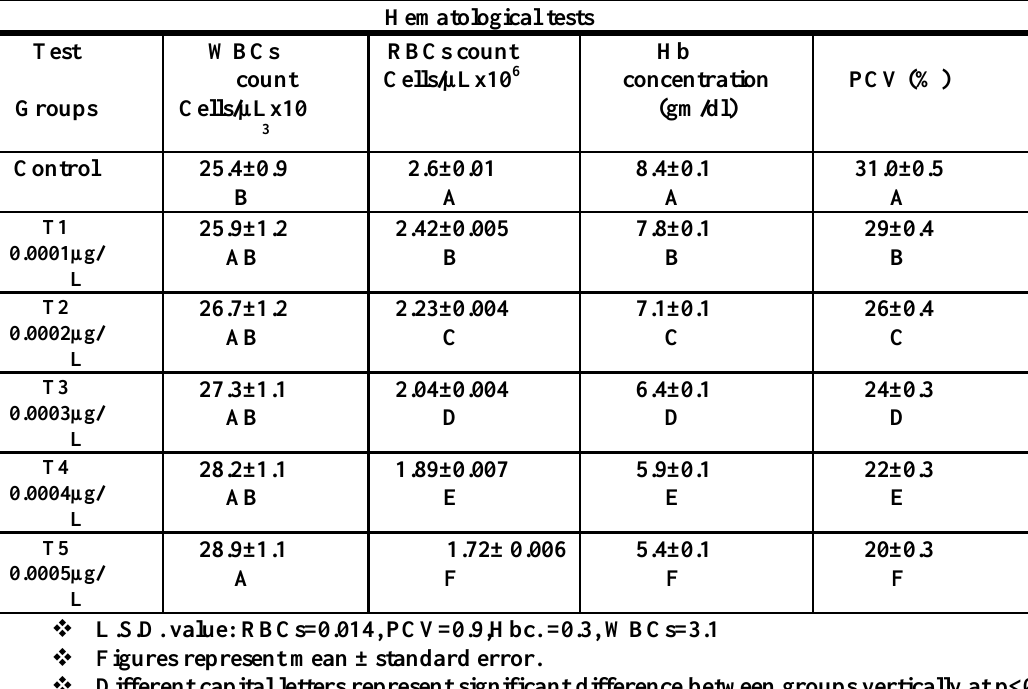
Table 2: The results of hematological tests (WBCs count, RBCs count, Hb concentration and PCV) of Cyprinus carpio which exposed to a repeated different concentration of Endosulfan pesticide during experiment